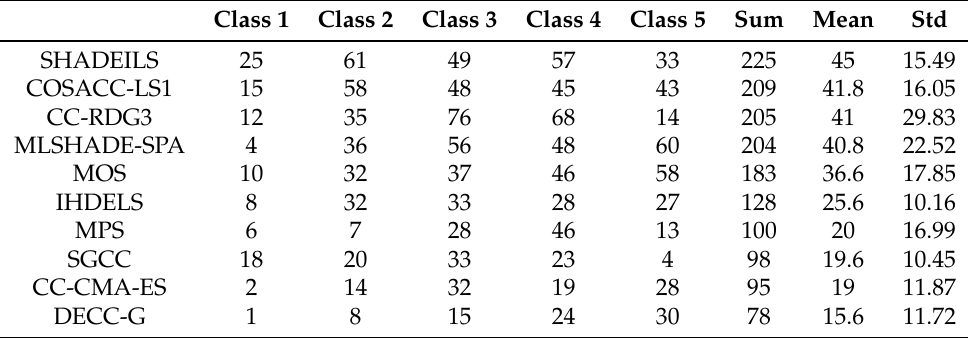
Table 5. Comparison of state-of-the-art